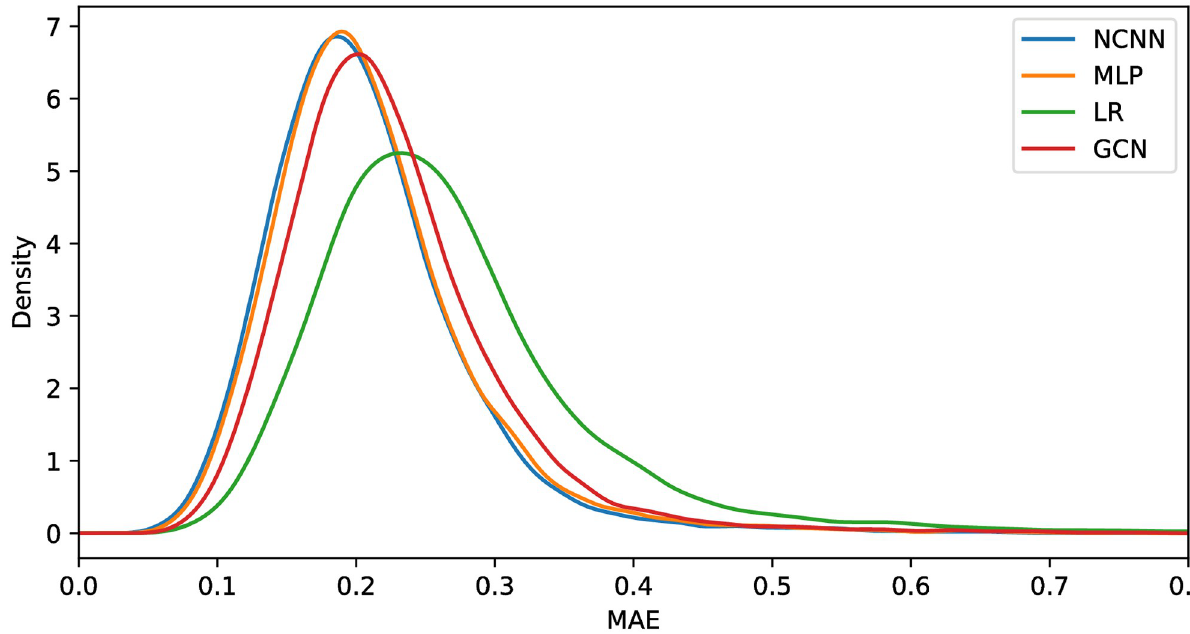
Fig 6. Density plot of different models with the best